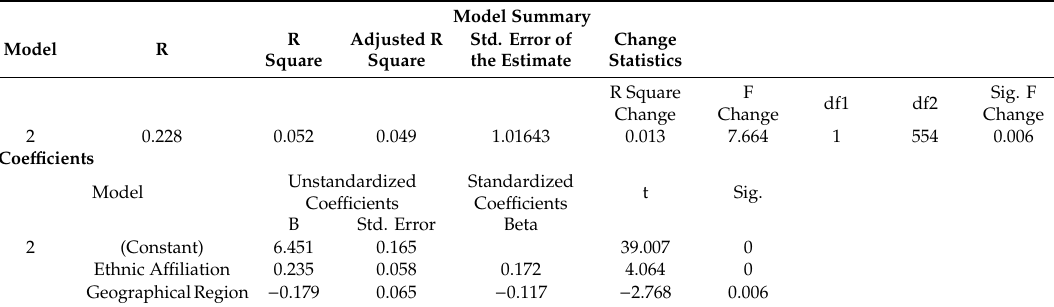
Table 1 o ff ers a summary of the relevant associations in the aforementioned regression model. Table 1. Factors a ff ecting commitment to the protection of the environment and open spaces.